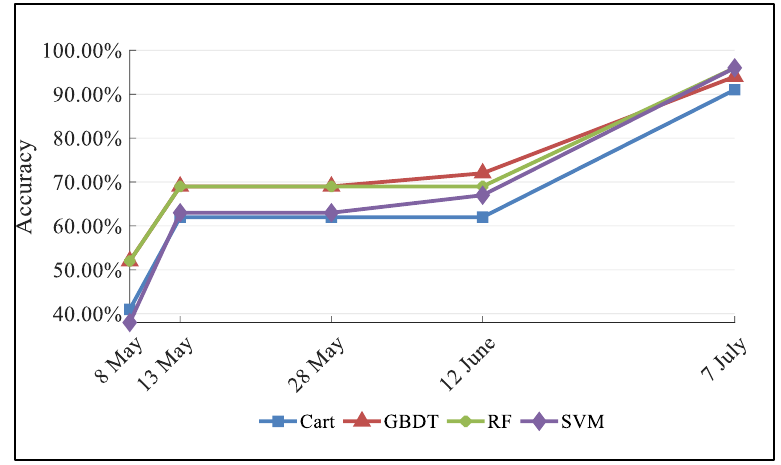
Figure 6. Maximum kappa coefficient changes of the classifiers in 2020 different periods.